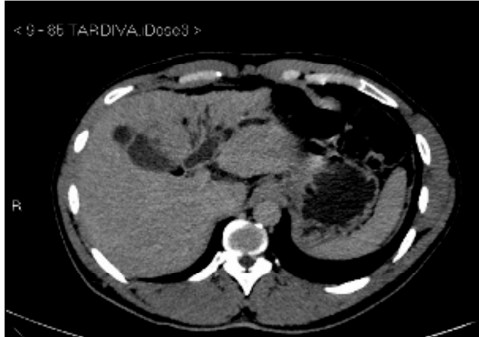
Figure 3. CT delayed phase.